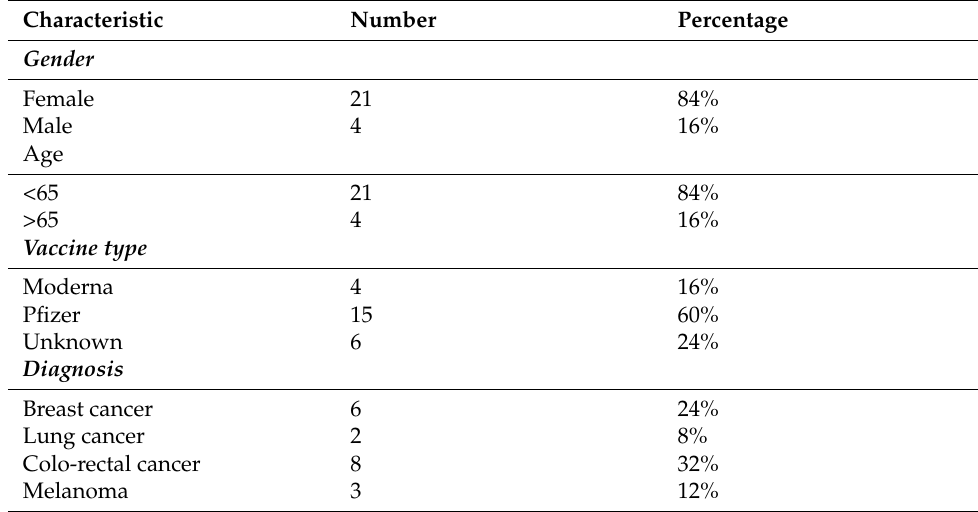
Table 1. Patient characteristics. Abbreviations: CUP—cancer of unknown